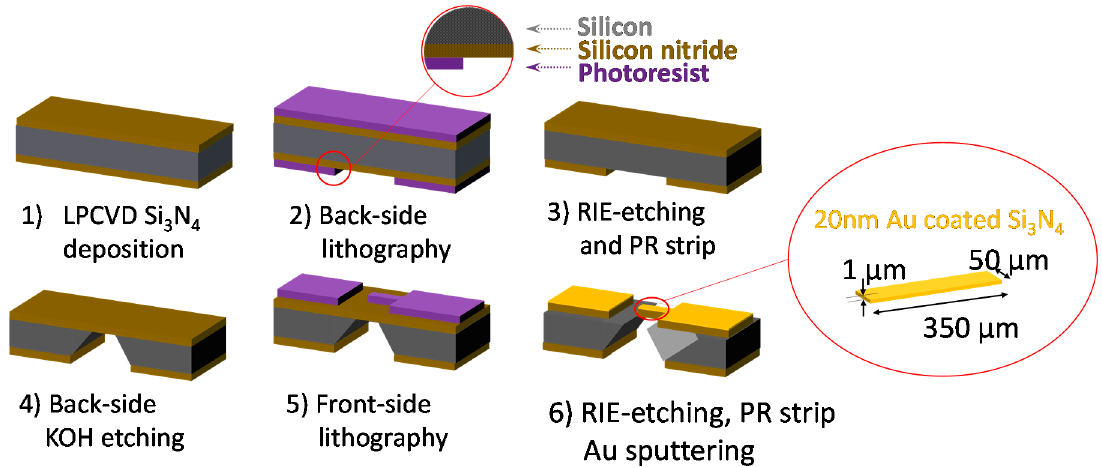
Figure 1. Microneedle fabrication process: (1) Low-Pressure Chemical Vapor Deposition (LPCVD) 1 µ m-thick low-stress silicon nitride (Si 3 N 4 ) film deposition; (2) Photolithography patterning on the back side; (3) Reactive ion etching (RIE) to open the back side and photoresist (PR) strip; (4) Anisotropic undercut etching of Si with potassium hydroxide (KOH); (5) Photolithography on front side; (6) RIE to define microneedle, PR strip, and 20 nm-thick gold (Au) sputtering for electrical conduction.